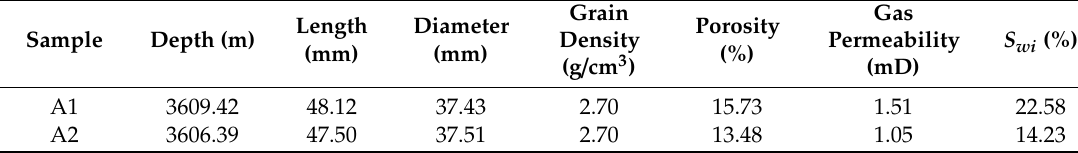
Table 1. The specifications of the core